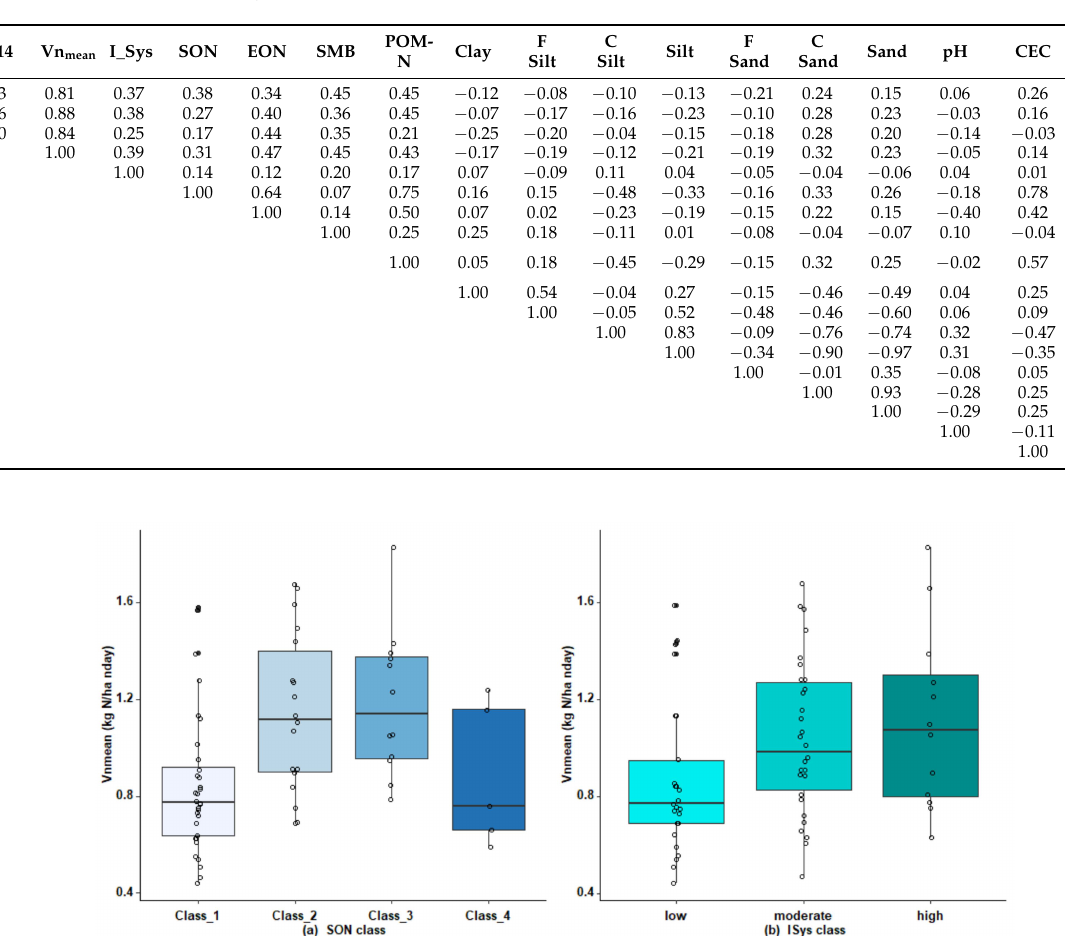
Table 3. Correlation coefficients (r) between Vn for the years 2012, 2013, 2014, Vn mean , the cropping system indicator (I_Sys), and soil properties for the 67 fields selected. ( p < 0.05 for r > 0.24, p < 0.01 for r > 0.31, and p < 0.001 for r > 0.39). F: fine, C: Coarse.